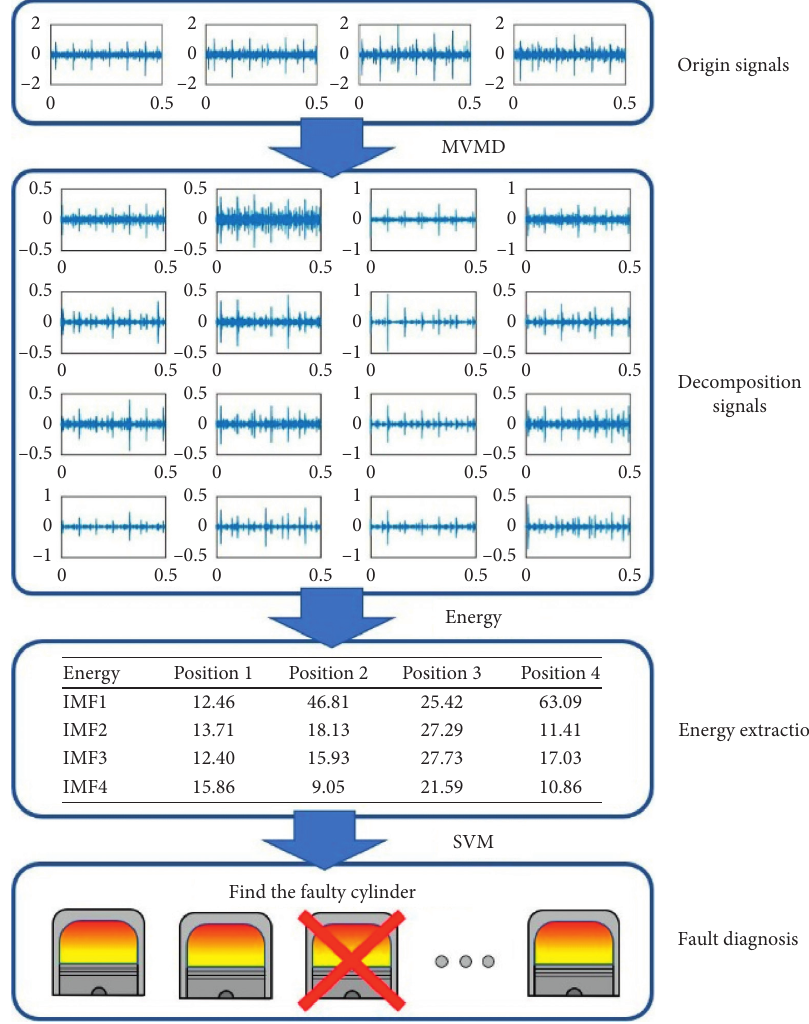
Figure 5: Fault diagnosis flowchart of diesel engine misfire.